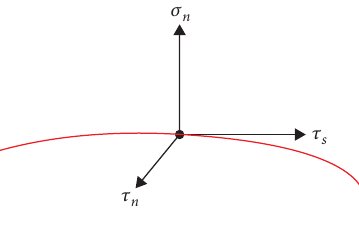
Figure 2: Local coordinate